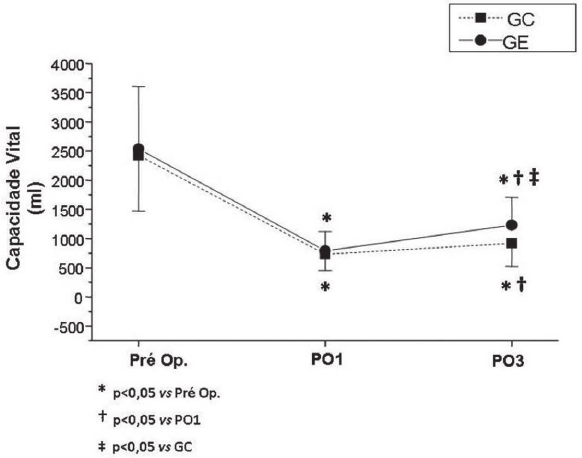
Fig. 4 - Evolução do valor da capacidade vital nos grupos estudados GC = grupo controle, GE = grupo estudo, CV = capacidade